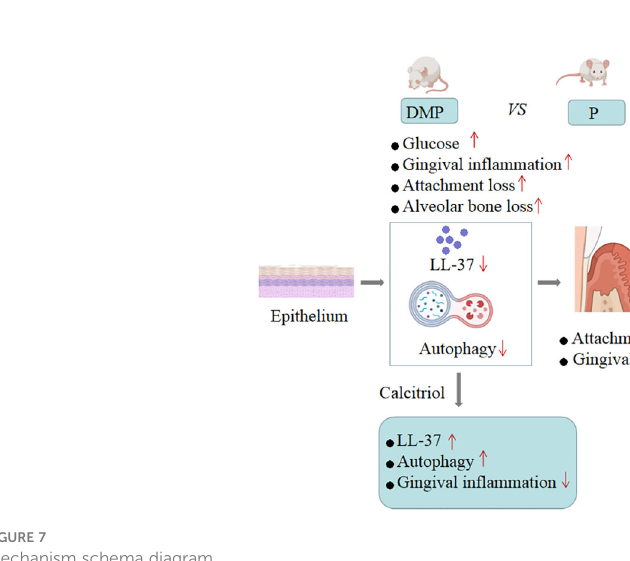
(Figure 6B j, n; Figure 6C q, s, t). In contrast, LL-37 expression decreased following intraperitoneal injection of 3-MA (Figure 6B k, o; Figure 6C q, s, t). LL-37-mediated suppression of 3-MA was apparently retrieved by calcitriol treatment (Figure 6B l, p; Figure 6C q, s, t).